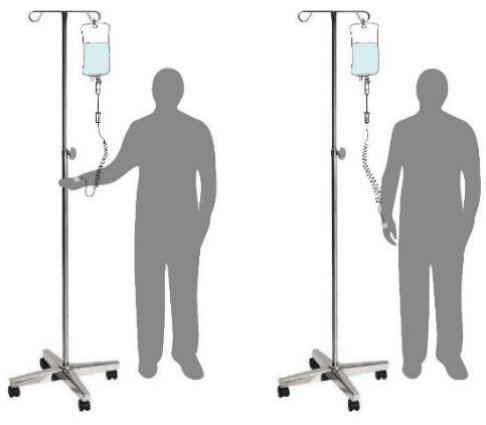
Figure 3. Traditional drip frame.